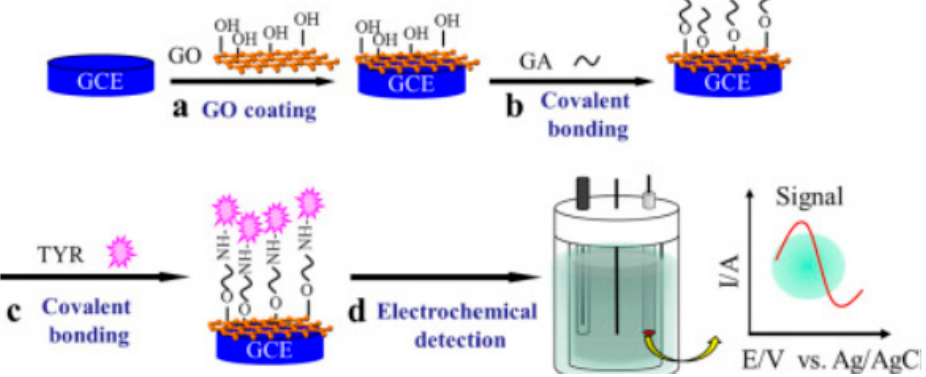
Figure 8. Schematic illustration of the TYR/GA/GO/GCE biosensor for the electrochemical deter- mination of phenol derivatives: ( a ), GO casting; ( b ), covalent bonding of GO and GA; ( c ), covalent bonding of GA and TYR; and ( d ), electrochemical detection of phenol derivatives. Reprinted with permission from [80]. Copyright 2023, copyright